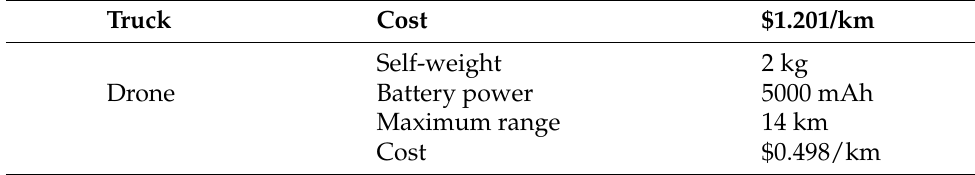
Table 3. The parameter settings of the truck and